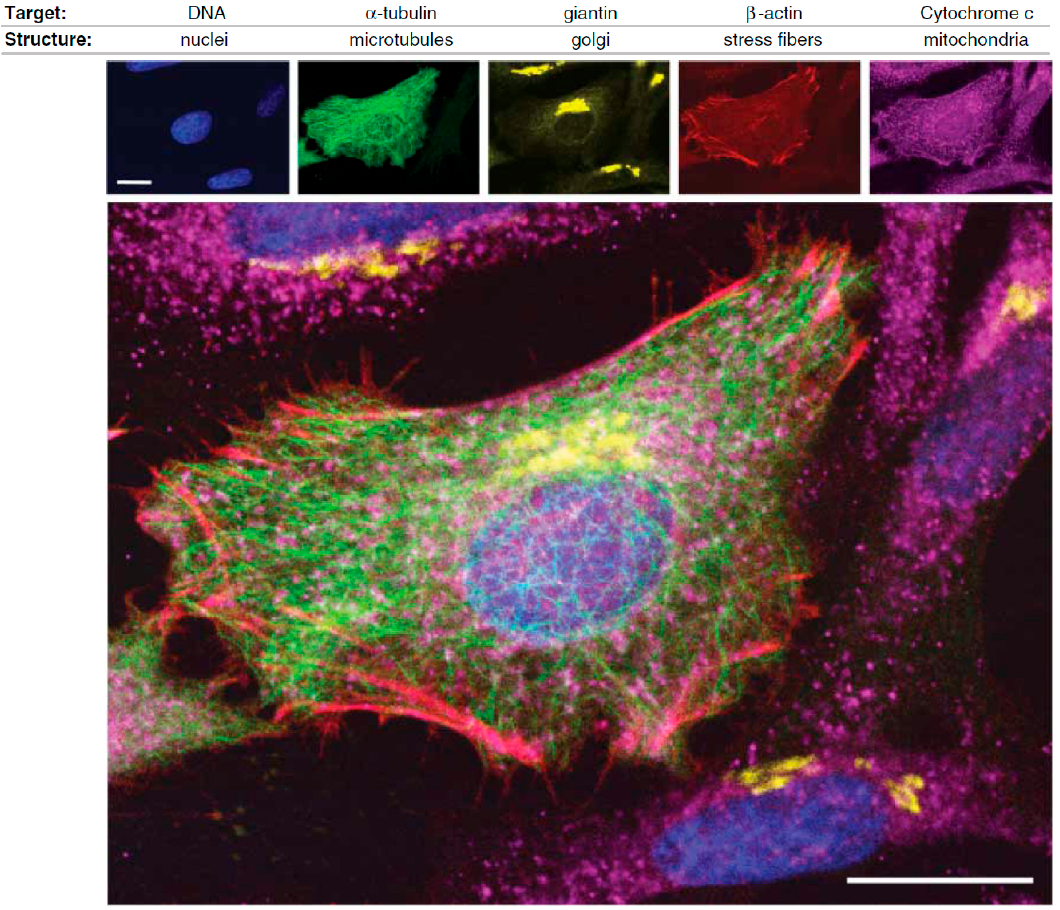
Figure 1. Illustration of the application of complementary fluorophores for the selective detection of different targets in HeLa cancer cells: DNA of nuclei (blue color), α -tubulin of microtubules (green color), giantin of Golgi bodies (yellow color), β -actin of stress fibers (red color), and Cytochrome c of mitochondria (purple color). Scale bars: 20 µ m (reprinted from [12] with permission, Copyright American Association for the Advancement of Science, 2006).